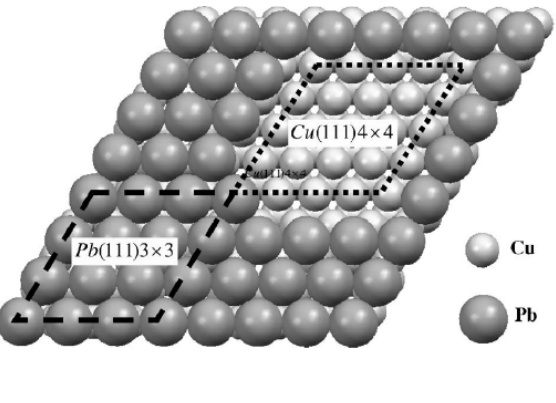
Figure 5. Pb/Cu(111) interface structure adopted in the analysis of showing a match between the 4 × 4 unit cell of Cu(111) and the 3 × 3 unit cell of Pb(111). From [27] (Copyright American Physical Society